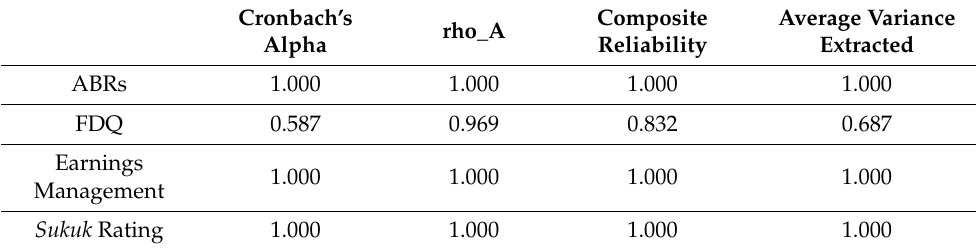
Table 4. Construct Reliability.